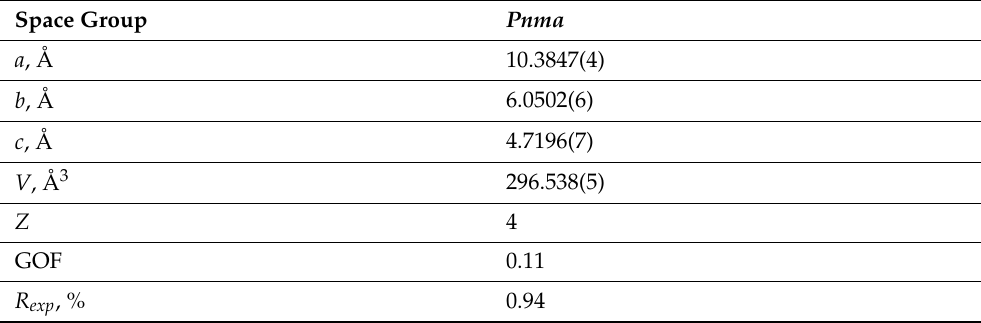
Table 1. Unit cell parameters determined from the PXRD